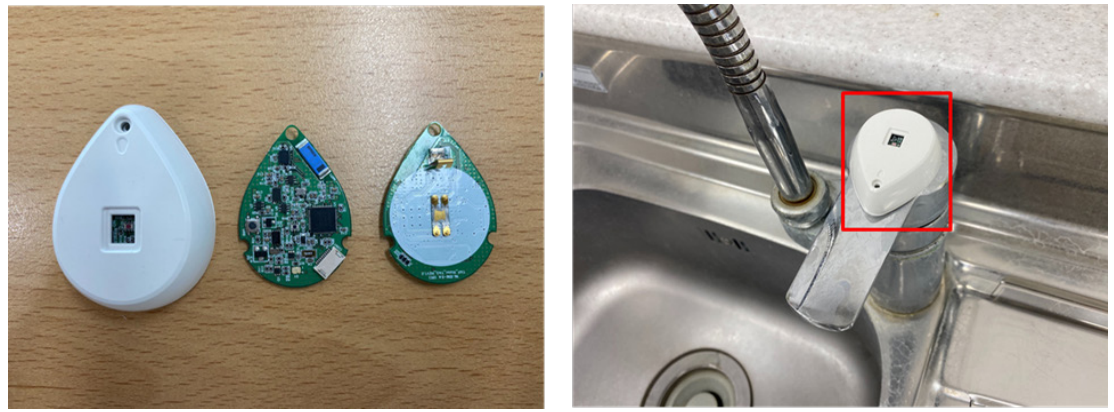
Figure 15. External Sensor Device (Faucet).